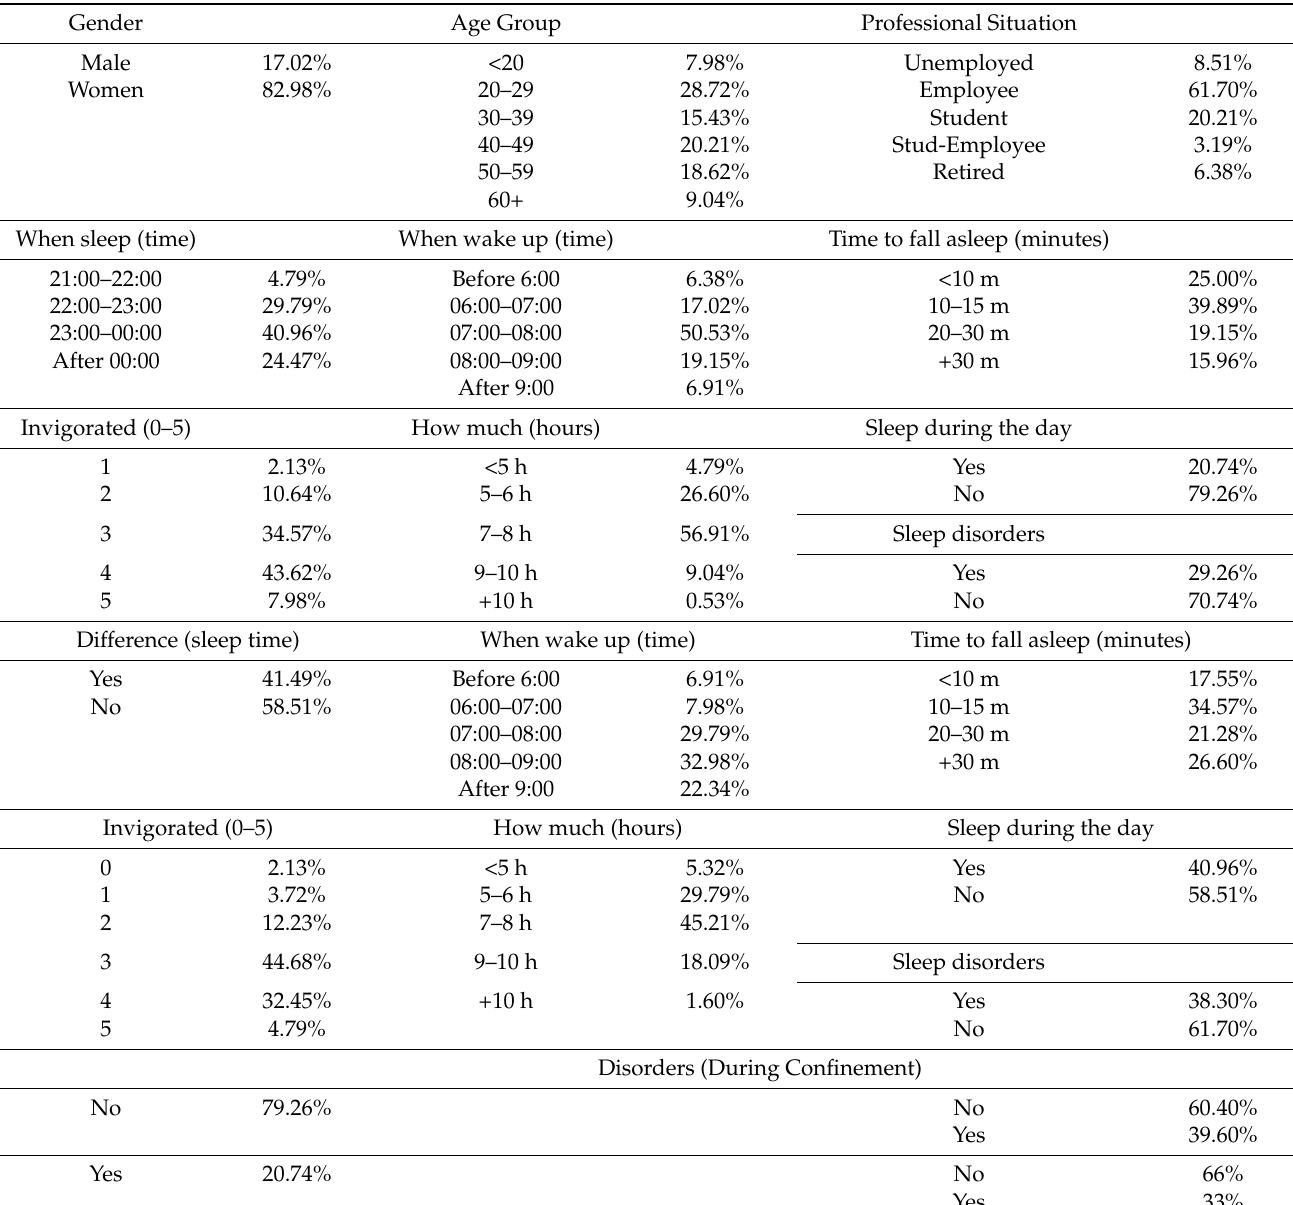
Table 1. Demographics (gender, age group, professional situation), pre-confinement sleep habits, confinement sleep habits, sleep disorders: before vs. during